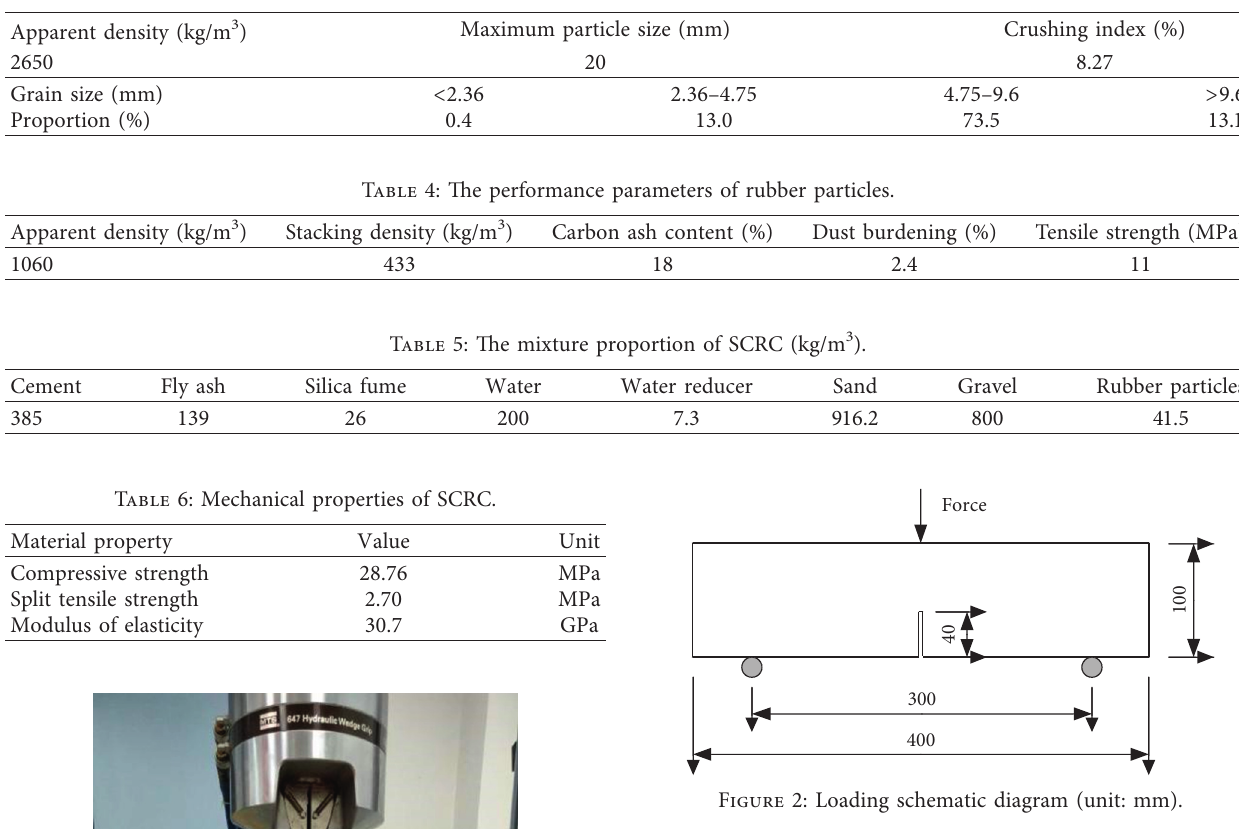
Table 3: Physical properties and gradation of crushed stone.